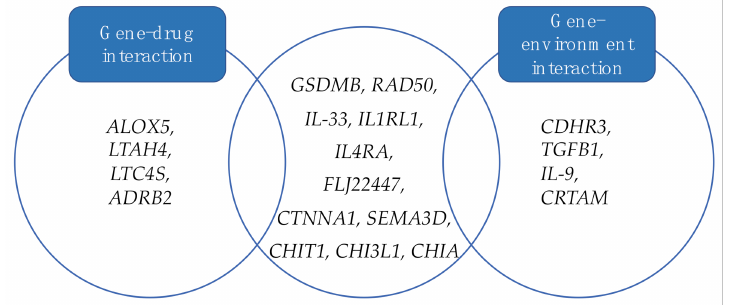
Figure 3. Genes implicated in asthma exacerbation pathogenesis, including gene-drug and gene- environment